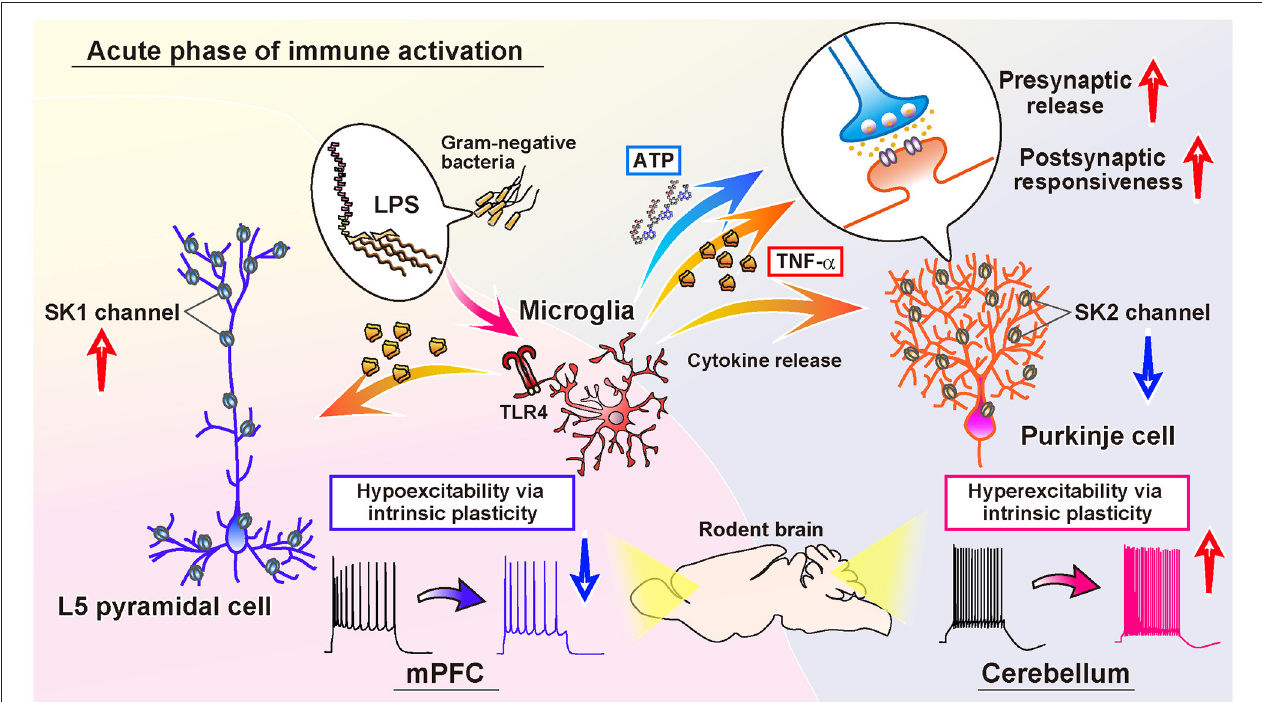
FIGURE 1 | Comparison of the immune-triggered plasticity of intrinsic excitability of cerebellar Purkinje cells and mPFC L5 pyramidal cells. Exposure to LPS activates microglia in both the cerebellum and mPFC. In the cerebellum, activated microglia release inflammatory cytokines, including TNF- α , which induce downregulation of SK2 channels in the Purkinje cells. Activated microglia also contribute to ATP release in the cerebellar cortex, and both ATP and TNF- α promote the release of presynaptic vesicles of the glutamatergic terminals. Moreover, the postsynaptic responsiveness is also increased via intraneuronal TNF-signaling. As a result, both the amplitude and frequency of both spontaneous and miniature EPSC increases ( Yamamoto et al., 2019). In the mPFC, TNF- α released from activated microglia causes the upregulation of SK1 channels of L5 pyramidal cells, in contrast to the cerebellum. Subsequently, the intrinsic excitability of L5 pyramidal cells is reduced long-lastingly. In addition, the frequency of spontaneous IPSC decreases, whereas the spontaneous EPSC does not change ( Yamawaki et al.,